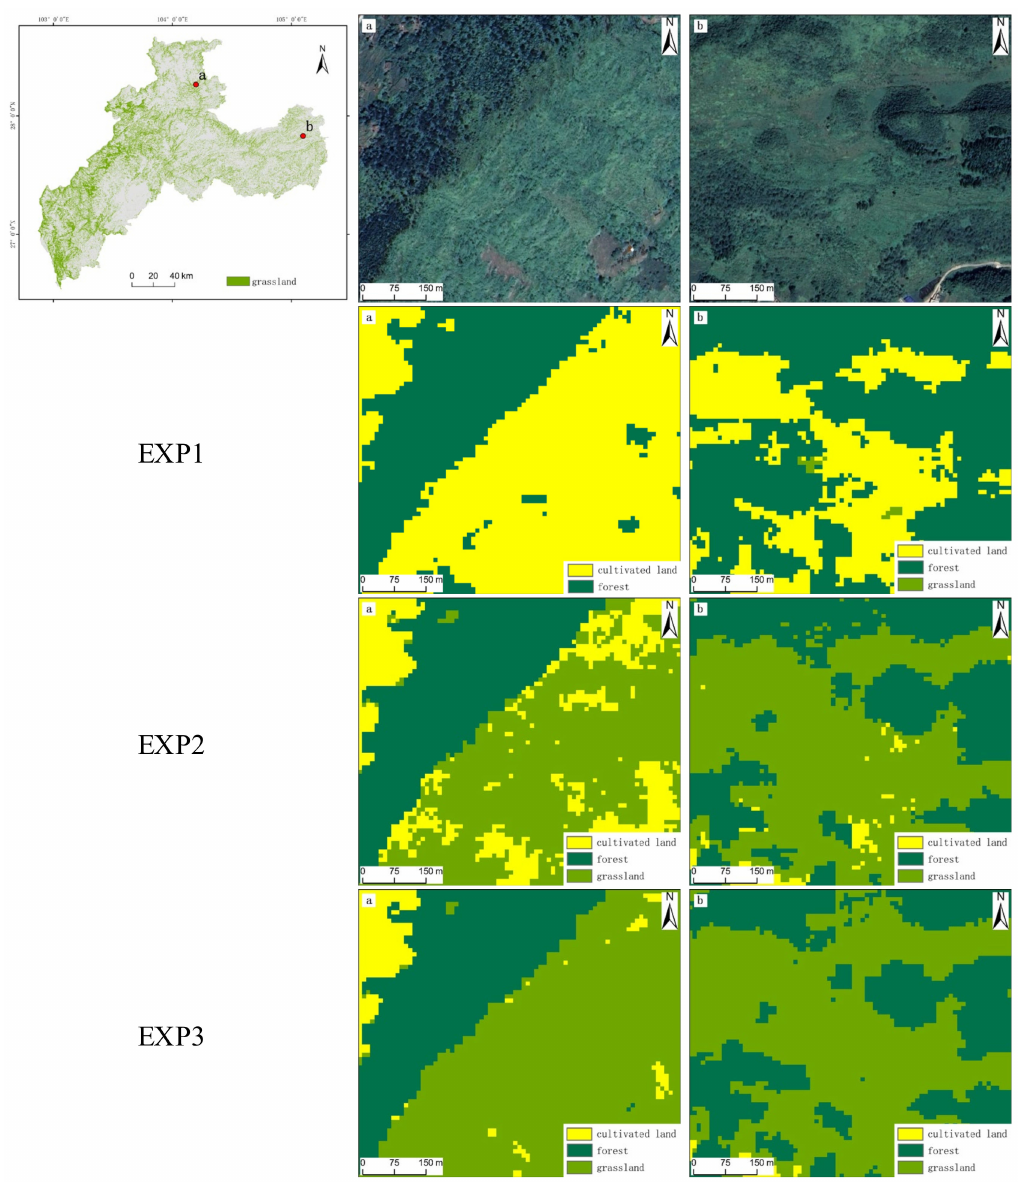
Figure 8. Examples of EXP1, EXP2, and EXP3 classification results. Region a is located on sunny slopes in the low land with steep slopes, and region b is located on sunny slopes in the middle land with steep